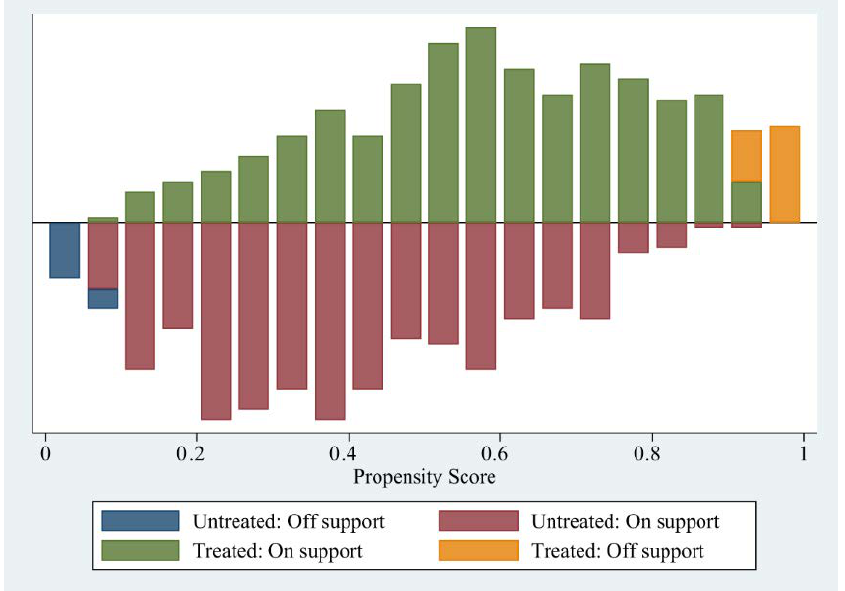
Figure 3. The common support region of propensity score. To ensure the robustness of the matching result, this study further employs the three matching methods, specifically k-nearest neighbor matching (K = 3), k-nearest neighbor matching (k = 4), and kernel matching (window width = 0.06), and the support areas of each method are found similar.